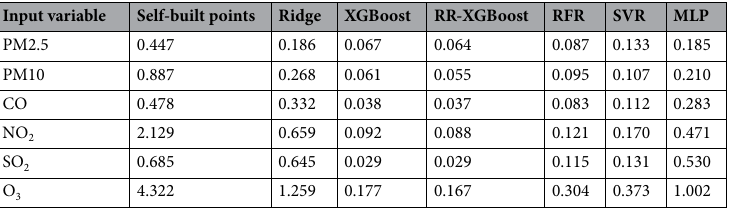
Table 5. MAPE of six types of air pollutant concentrations between self-built points, model forecast values and national control point.